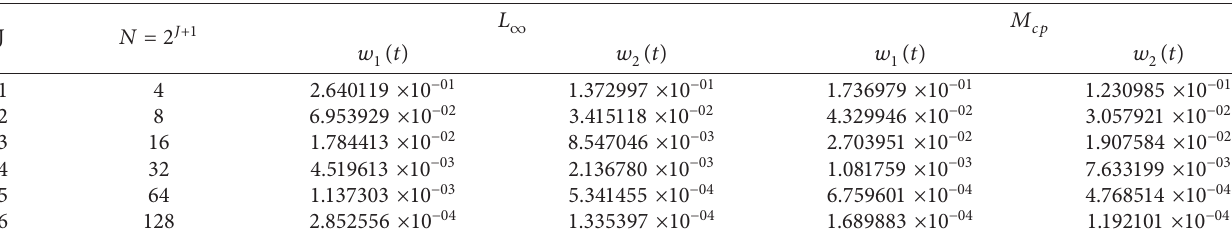
Table 4: L and M cp errors for Problem 4. ∞